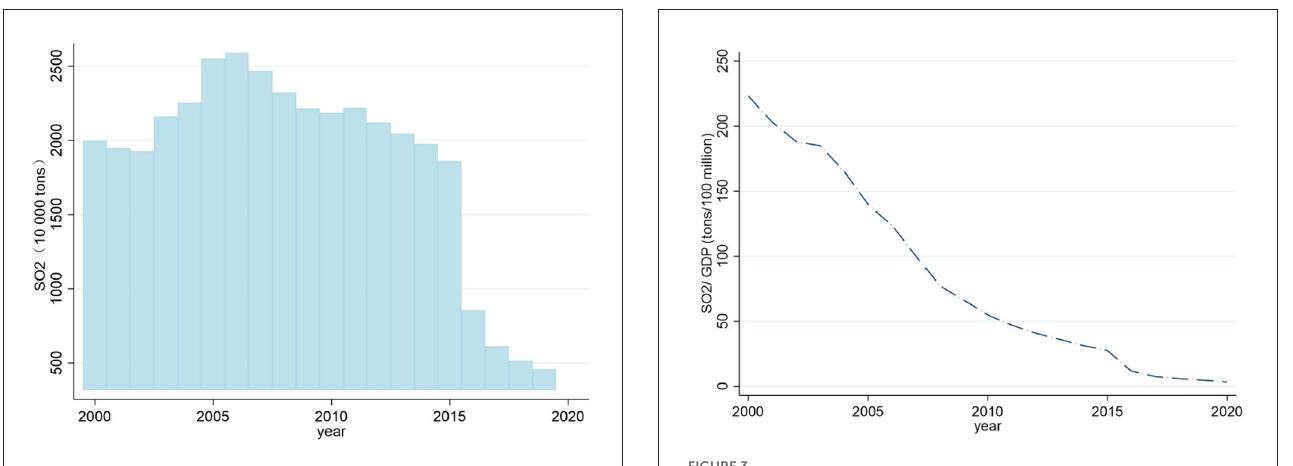
FIGURE2 National sulfur dioxide emission changes from 2000 to 2020.